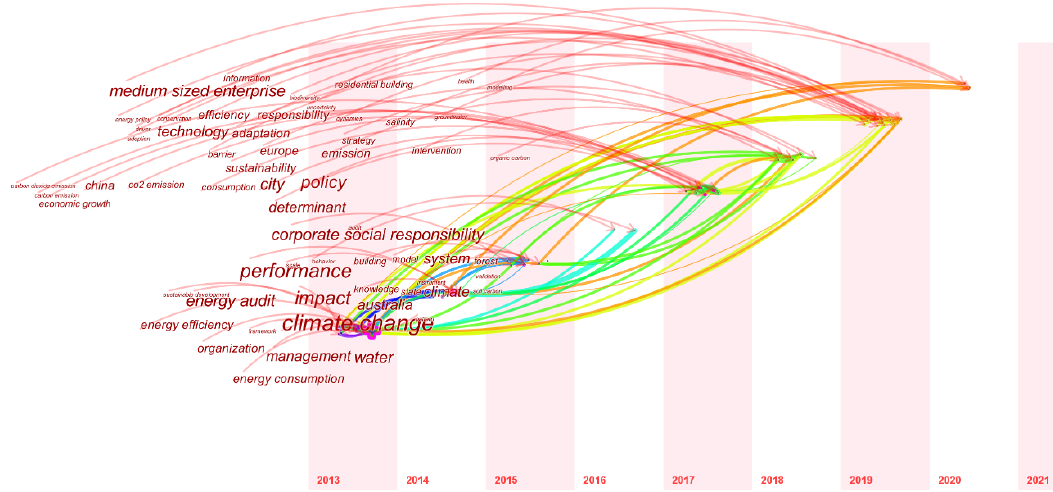
Figure 10. A visualization of the keyword time zone map .